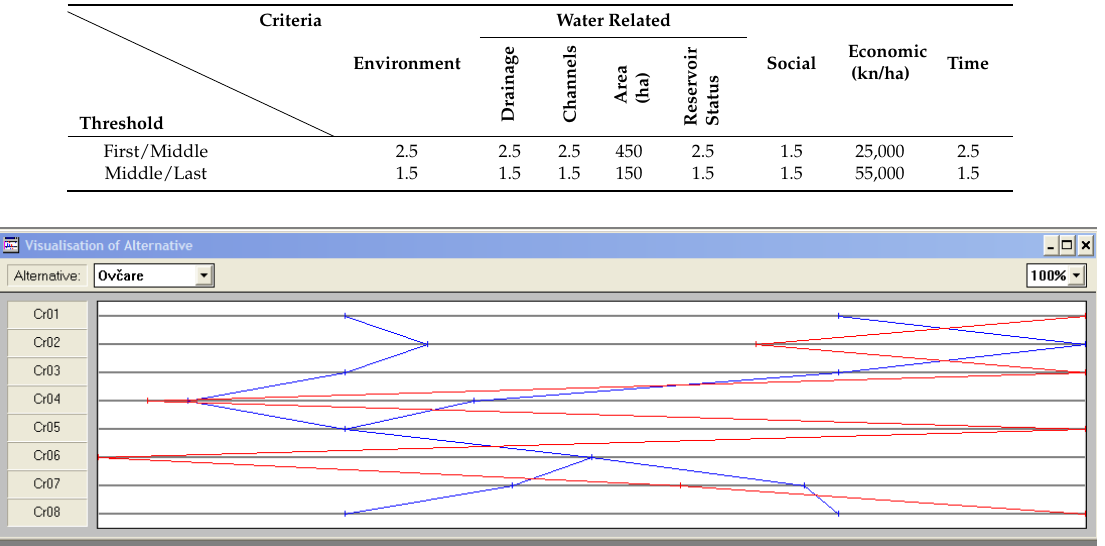
Table 7. Thresholds between categories.